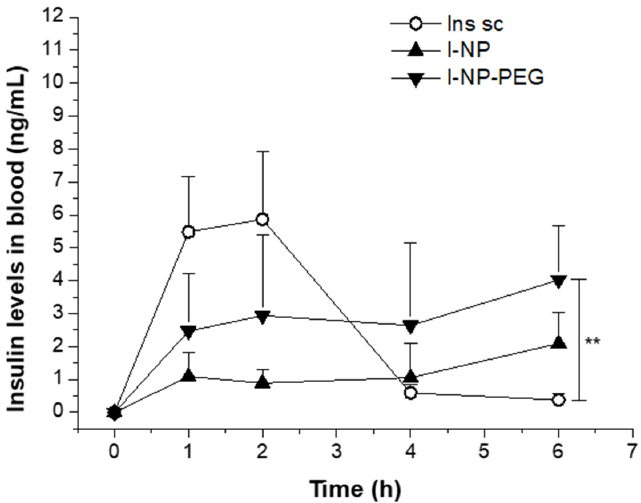
Figure 9. Serum insulin levels vs time after the subcutaneous administration of an insulin solution (Ins sc; 5 IU/Kg) or oral administration insulin-loaded bare nanoparticles (I-NP; 50 IU/Kg), or insulin-loaded PEG-coated nanoparticles (I-NP-PEG; 50 IU/Kg). Data expressed as mean ± S.D. ( n ≥ 6). **: p < 0.01. Table 3. Pharmacokinetic parameters of insulin administered either subcutaneously or orally. Ins sc: subcutaneous insulin (5 IU/kg); I-NP: insulin-loaded bare nanoparticles (50 IU/kg); I-NP-PEG: insulin-loaded PEG-coated nanoparticles (50 IU/kg); C max : maximum plasma concentration; Tmax: time when the maximum plasma levels of insulin were achieved; AUC: area under the curve; Fr%: oral bioavailability relative to subcutaneous administrations. Data expressed as mean ± SD ( n = 6). *: p < 0.05 compared to Ins sc. **: p < 0.01 compared to Ins sc. Treatment